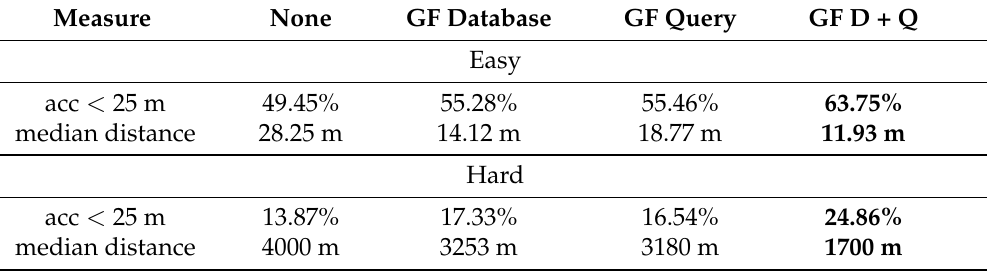
Table 3. Results under different graph filter conditions for the Mapiliary Sydney dataset. GF means Graph Filtering. The best performance for each row is